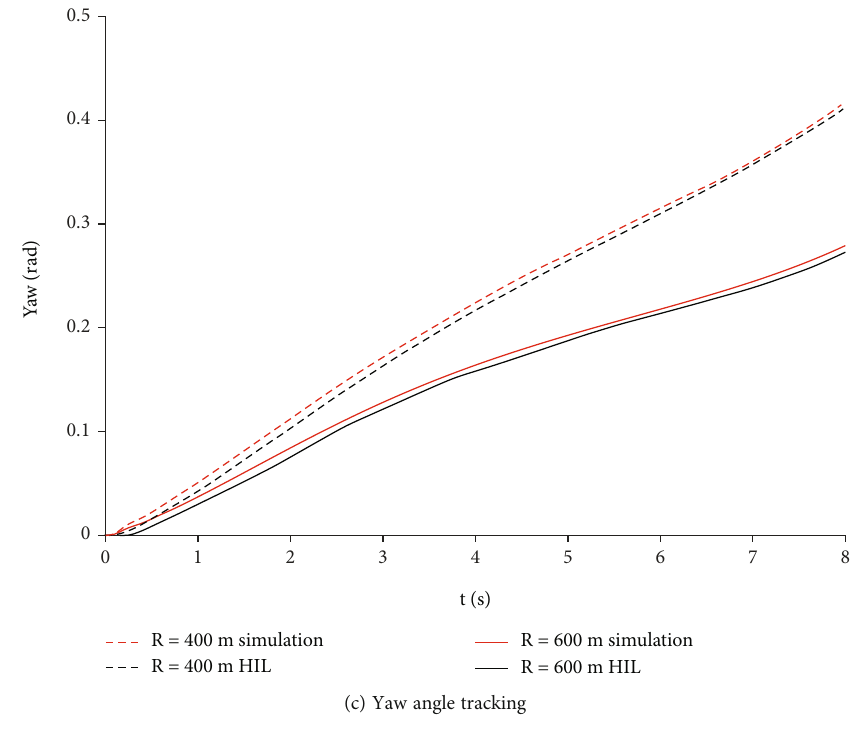
Figure 7: HIL test